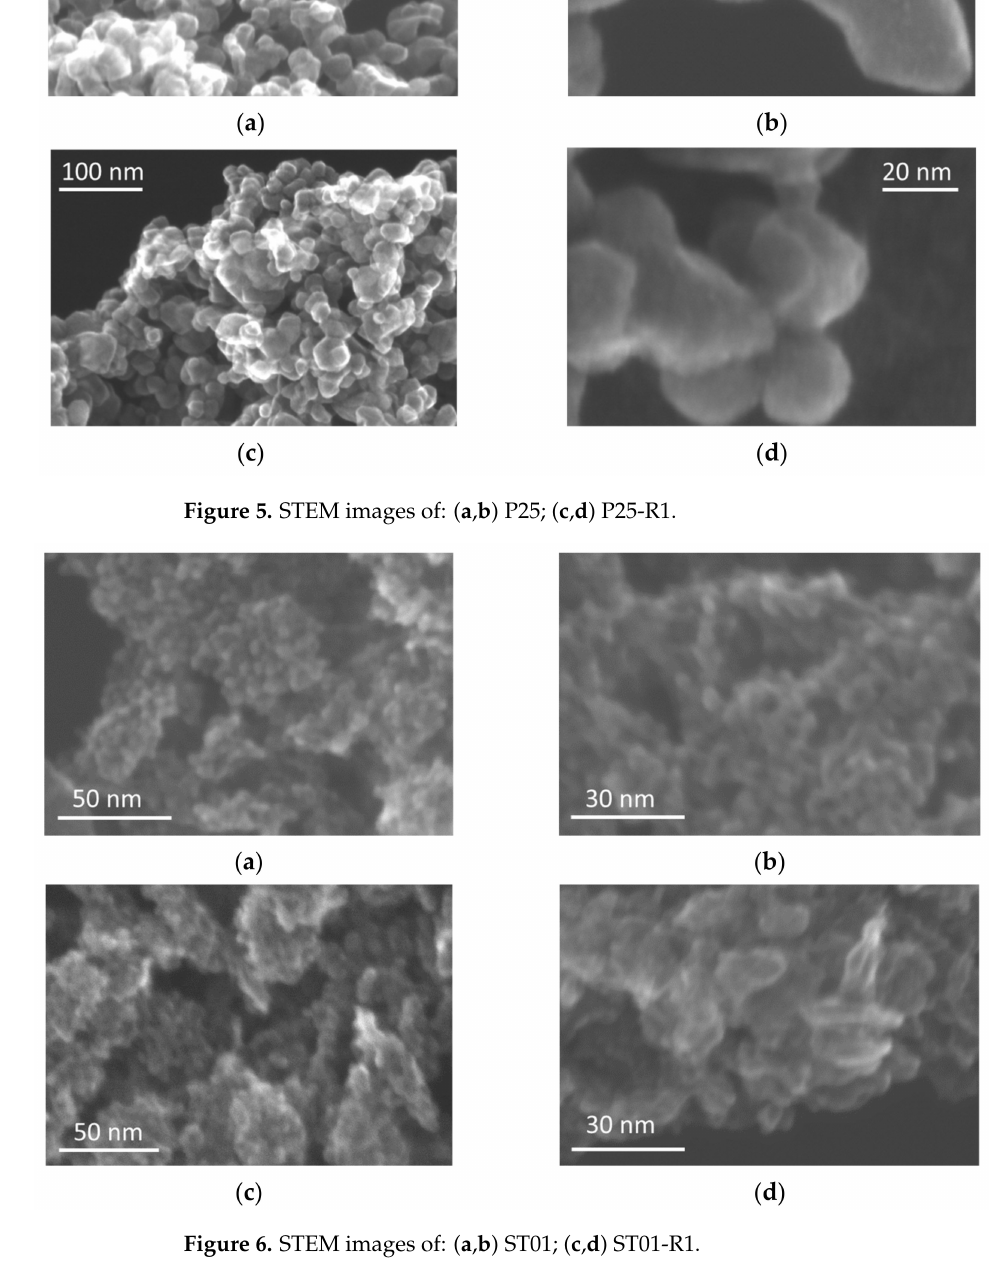
Figure 6. STEM images of: ( a , b ) ST01; ( c , d )